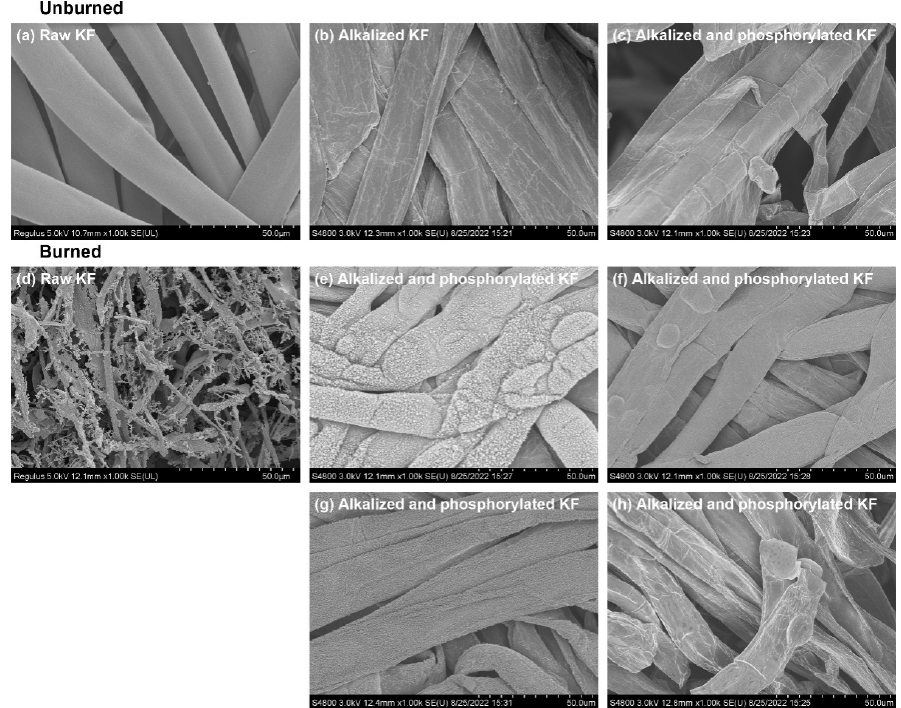
Figure 10. SEM micrographs of raw, alkalized, and phosphorylated KF sheets before and after combustion: Sheet samples: ( a , d – g ) and loose fiber samples: ( b , c , h ); ( e , f ) were collected from two sides of residual char in the middle of burned KF sheet; g was collected from the upper residual char of burned KF sheet; phosphorylated KF sample was obtained using 6 g PA.